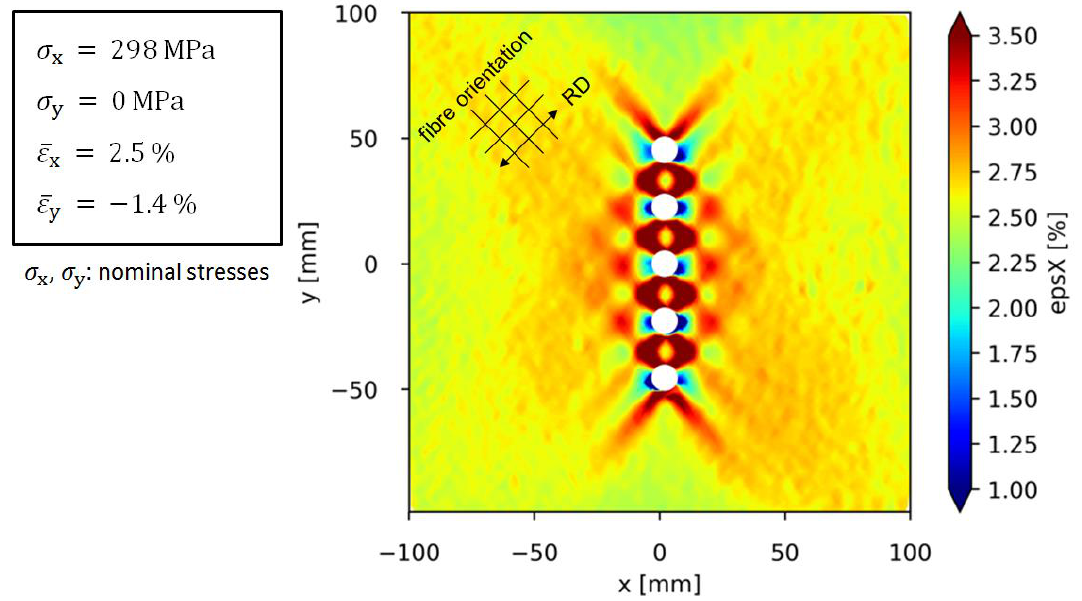
Figure 7. Strain field near blunt notch pattern obtained by DIC for off-axis angle of 45° and λ = 0.